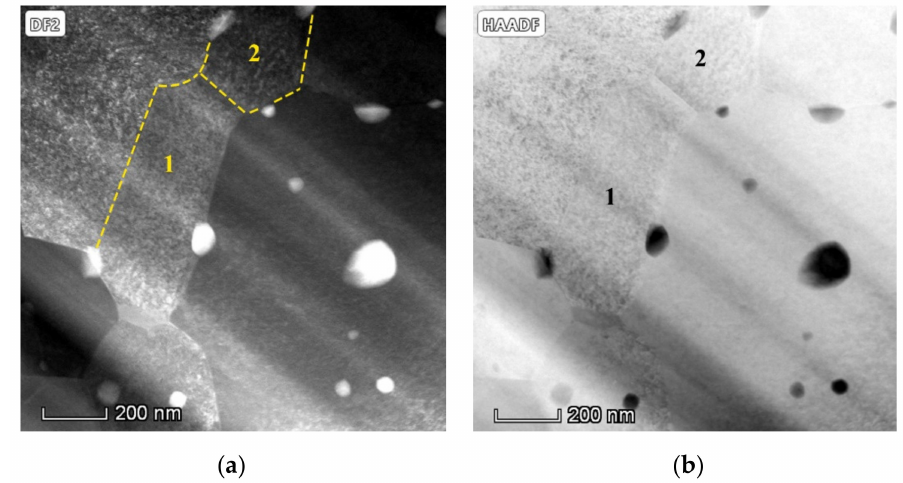
Figure 7. ( a ) Dark-field (DF) and ( b ) high-angle annular dark-field (HAADF) TEM images of the sintered W-TiC alloys, the dotted line in ( a ) marks the sub-grain boundaries, and the numbers 1 and 2 indicate the two